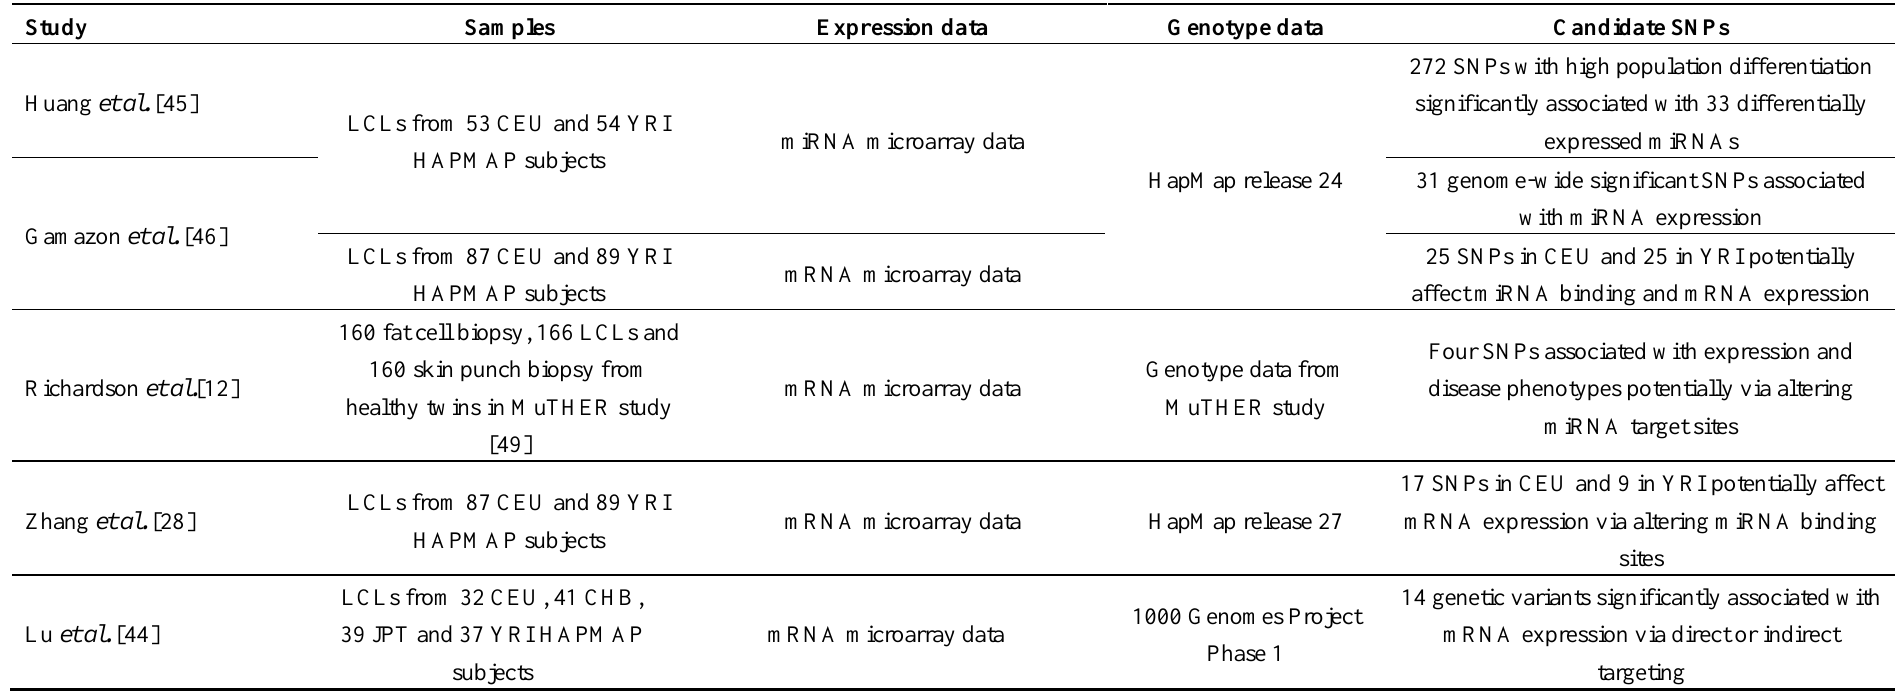
Table 3. Summary of Studies on SNPs Associated with MiRNA or Target Gene